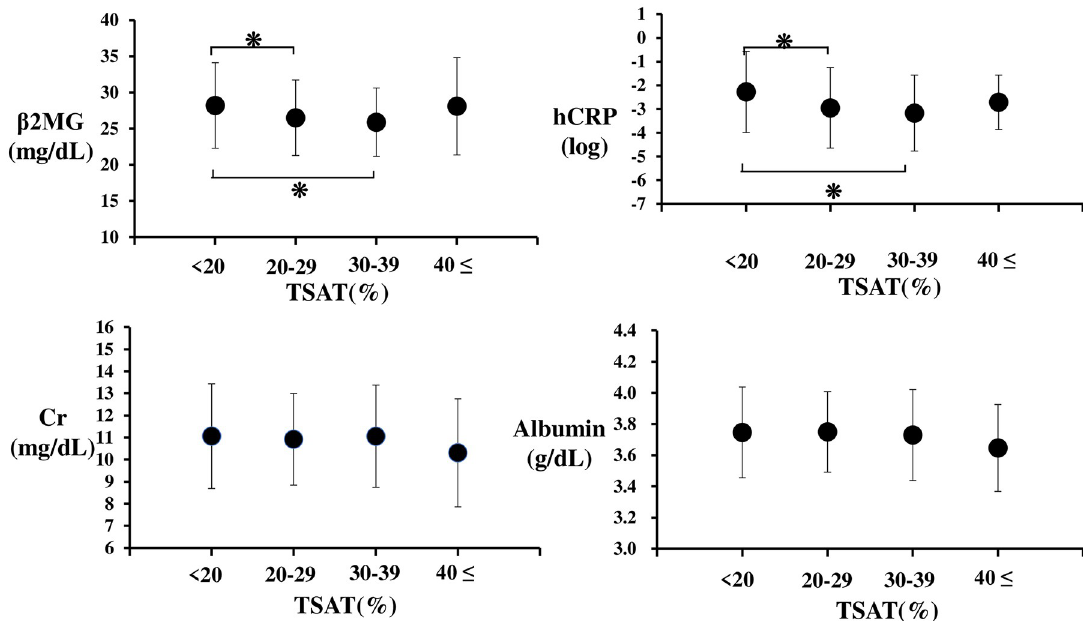
Fig 3. Comparison of clinical parameters among patients with various TSAT levels. There was no significant difference in the serum Cr and albumin levels among TSAT groups. On the other hand, serum β 2-MG and hCRP levels in patients with TSAT levels under 20% were significantly higher than in patients with TSAT levels of 20–29 and 30–39%. ❋ : p < 0.05, Data represent means ±